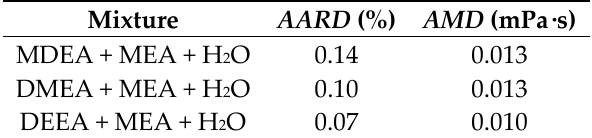
Table 17. Average absolute relative ( AARD ) and absolute maximum ( AMD ) deviations calculated based on correlations proposed using Equations (12)–(14).